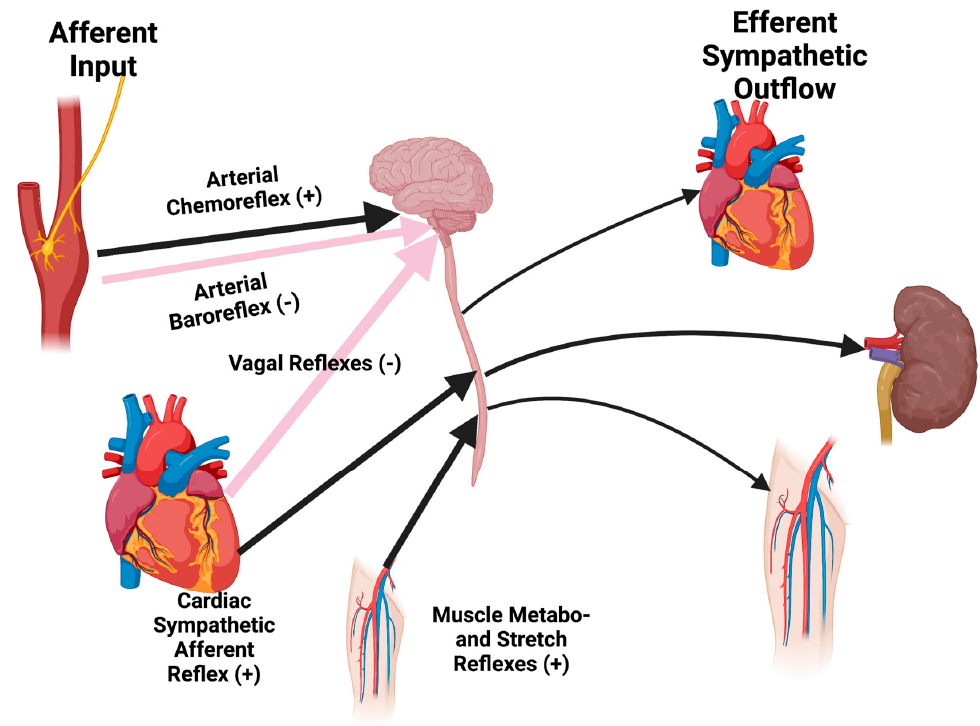
Figure 2. Heart failure is associated with abnormalities in both inhibitory and excitatory cardiovascular reflexes emanating from the periphery and the heart itself. These abnormal reflexes result in an increase in sympathetic outflow to the heart, peripheral vasculature, and kidney.